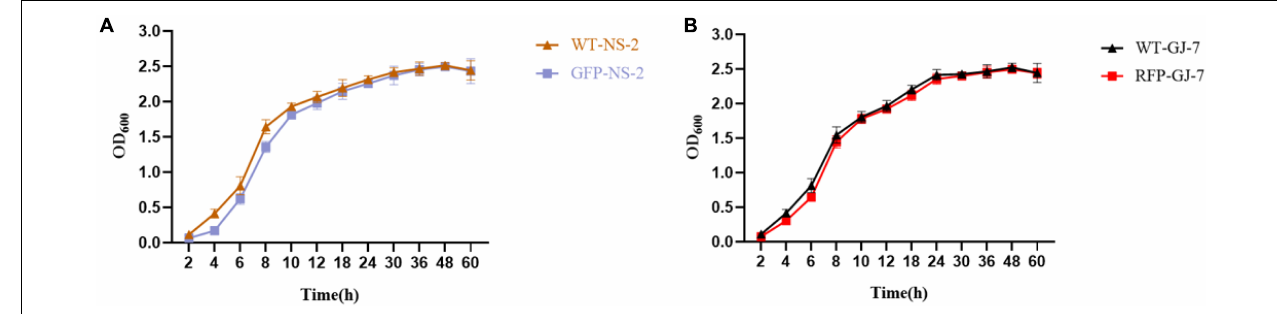
FIGURE 5 | The growth rate of the tagged strain compared with the wild-type strain. OD 600 measures were used to determine bacterial growth rate. (A) Growth rate of the strain NS-2. (B) Growth rate of the strain GJ-7. Three replicates were included.